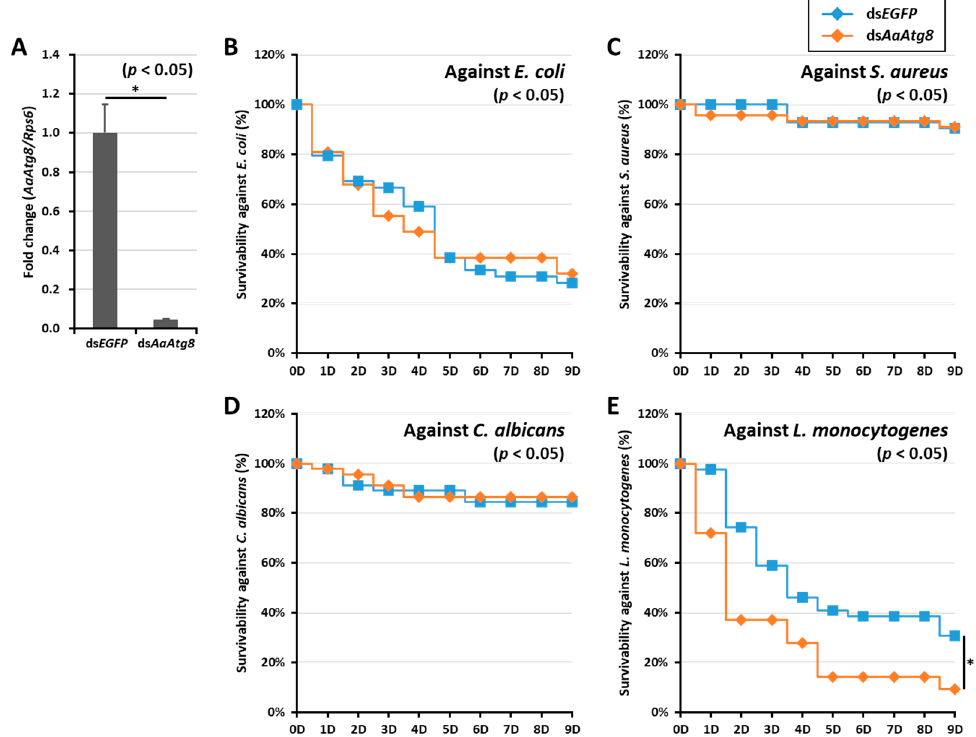
Figure 5. Effects of AaAtg8 mRNA silencing on microorganism infection in sugar-fed Ae. albopictus mosquitoes. ( A ) RNAi efficiency of AaAtg8 mRNA in ds AaAtg8 -injected adult mosquito group ( n >